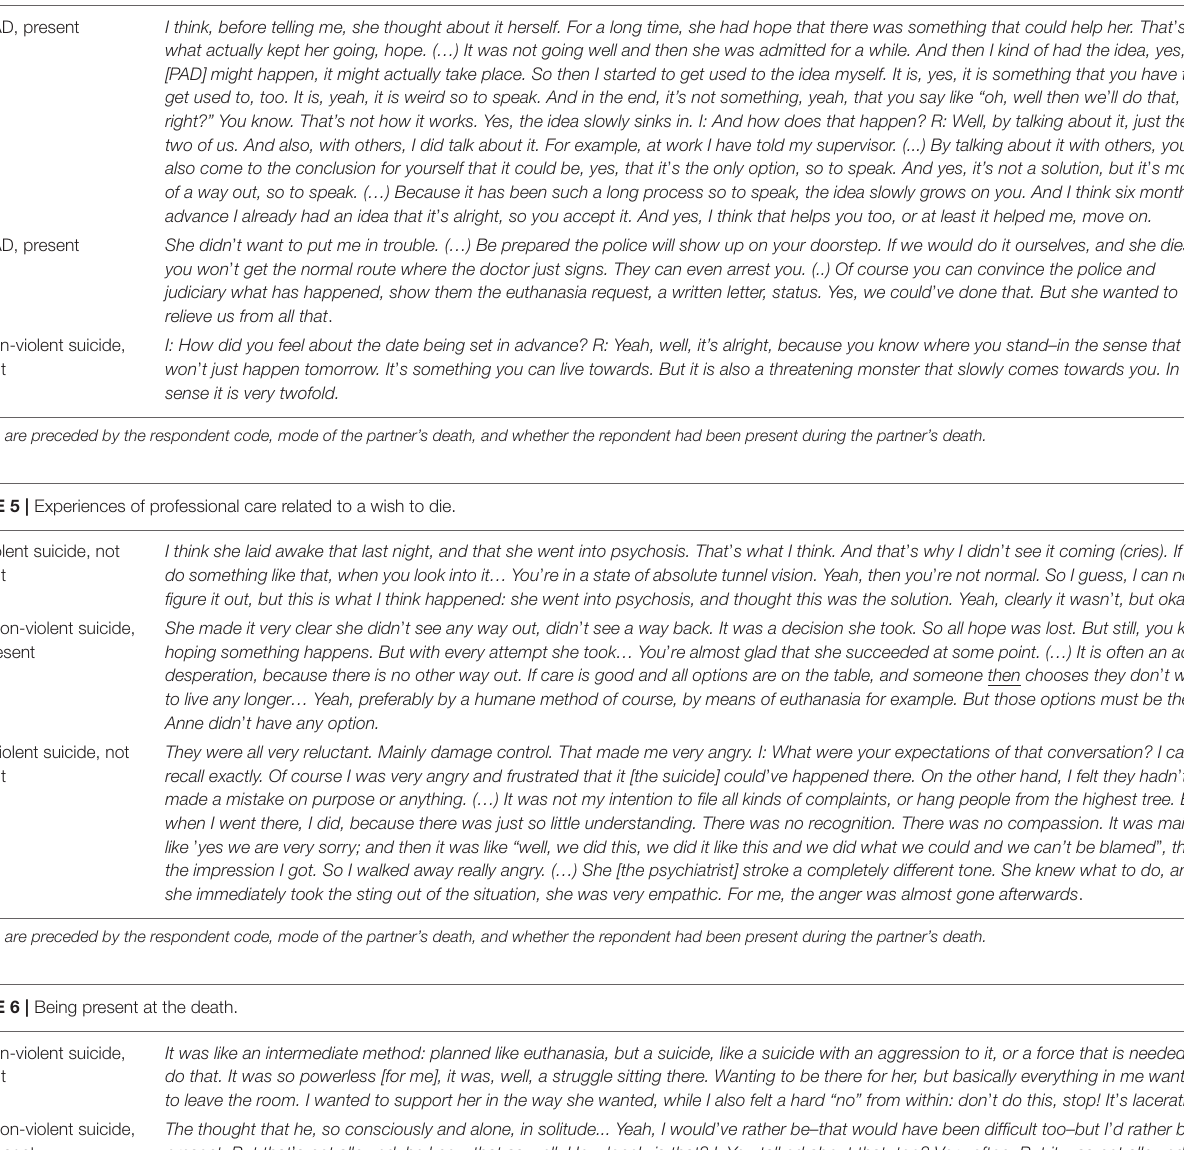
TABLE 4 | Anticipating partner’s